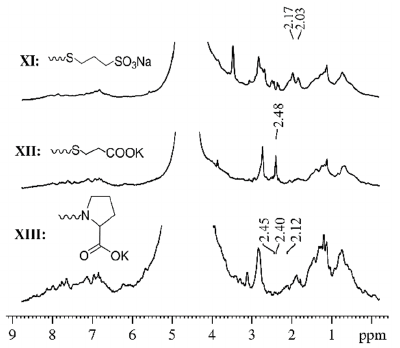
Figure 10. The 1 H spectra of the RBCs suspensions with added compounds XI – XIII .